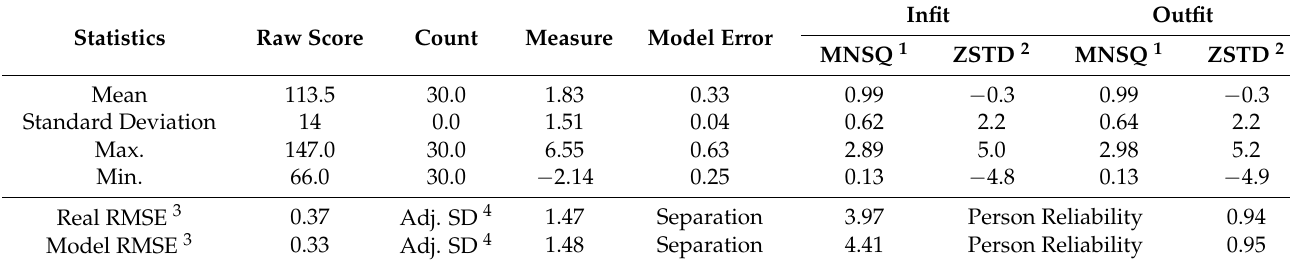
Table 10. Statistical summary of individuals (innovative behaviour).